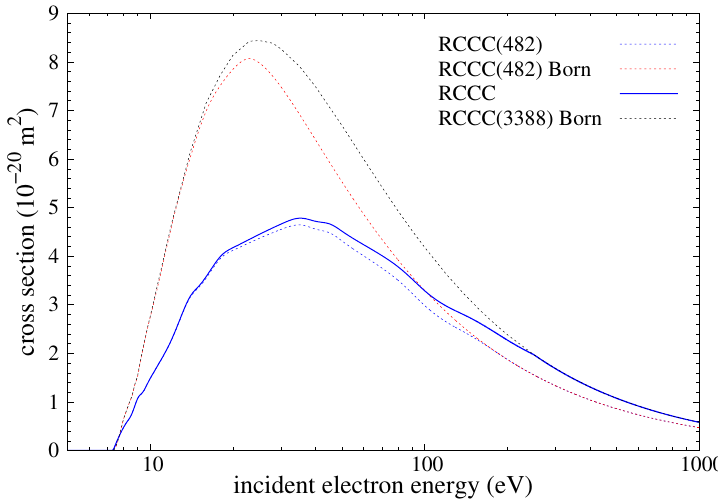
Figure 18. Extrapolation of the direct ionisation cross section for the 5 p 2 3 P 0 ground